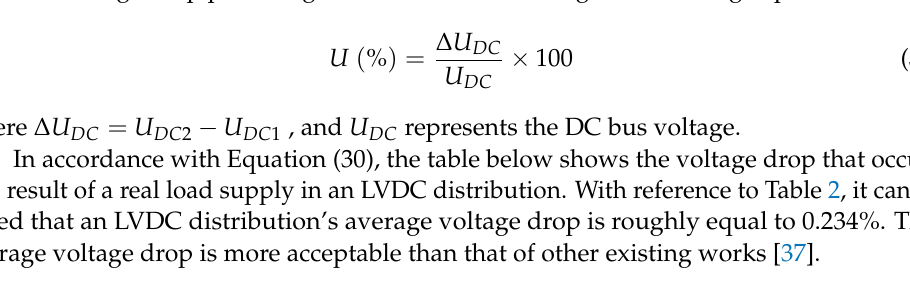
Table 2. LVDC voltage drops.